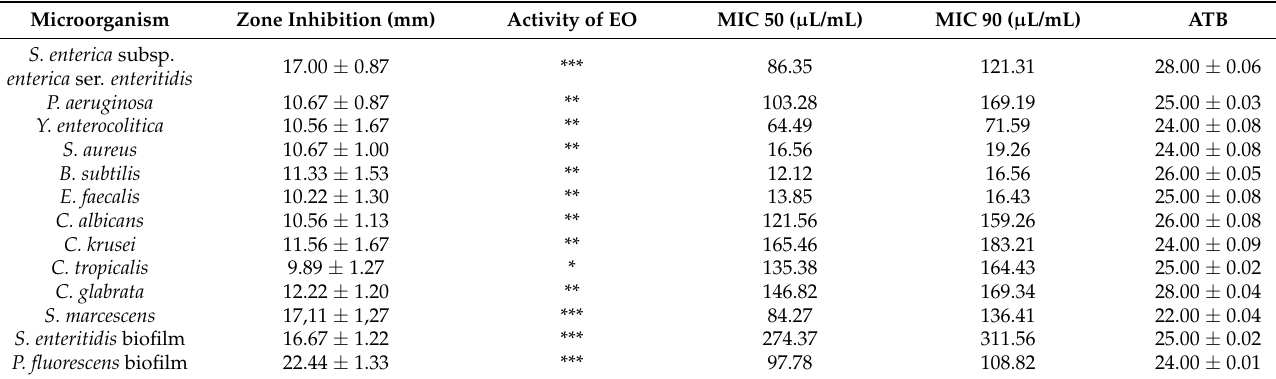
Table 2. Antimicrobial activity of essential oil of T. vulgaris